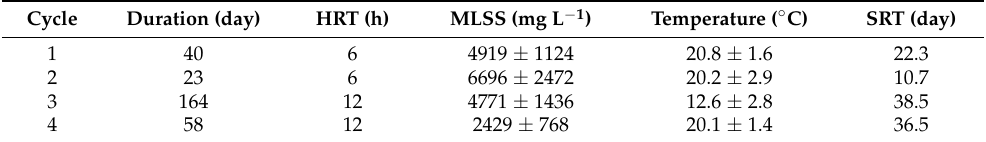
Table 1. Operation conditions of hydraulic retention time (HRT), mixed liquor suspended solids (MLSS), temperature and solids retention time (SRT) in each cycle for steady state. Cycle Duration (day) HRT (h) MLSS (mg L − 1